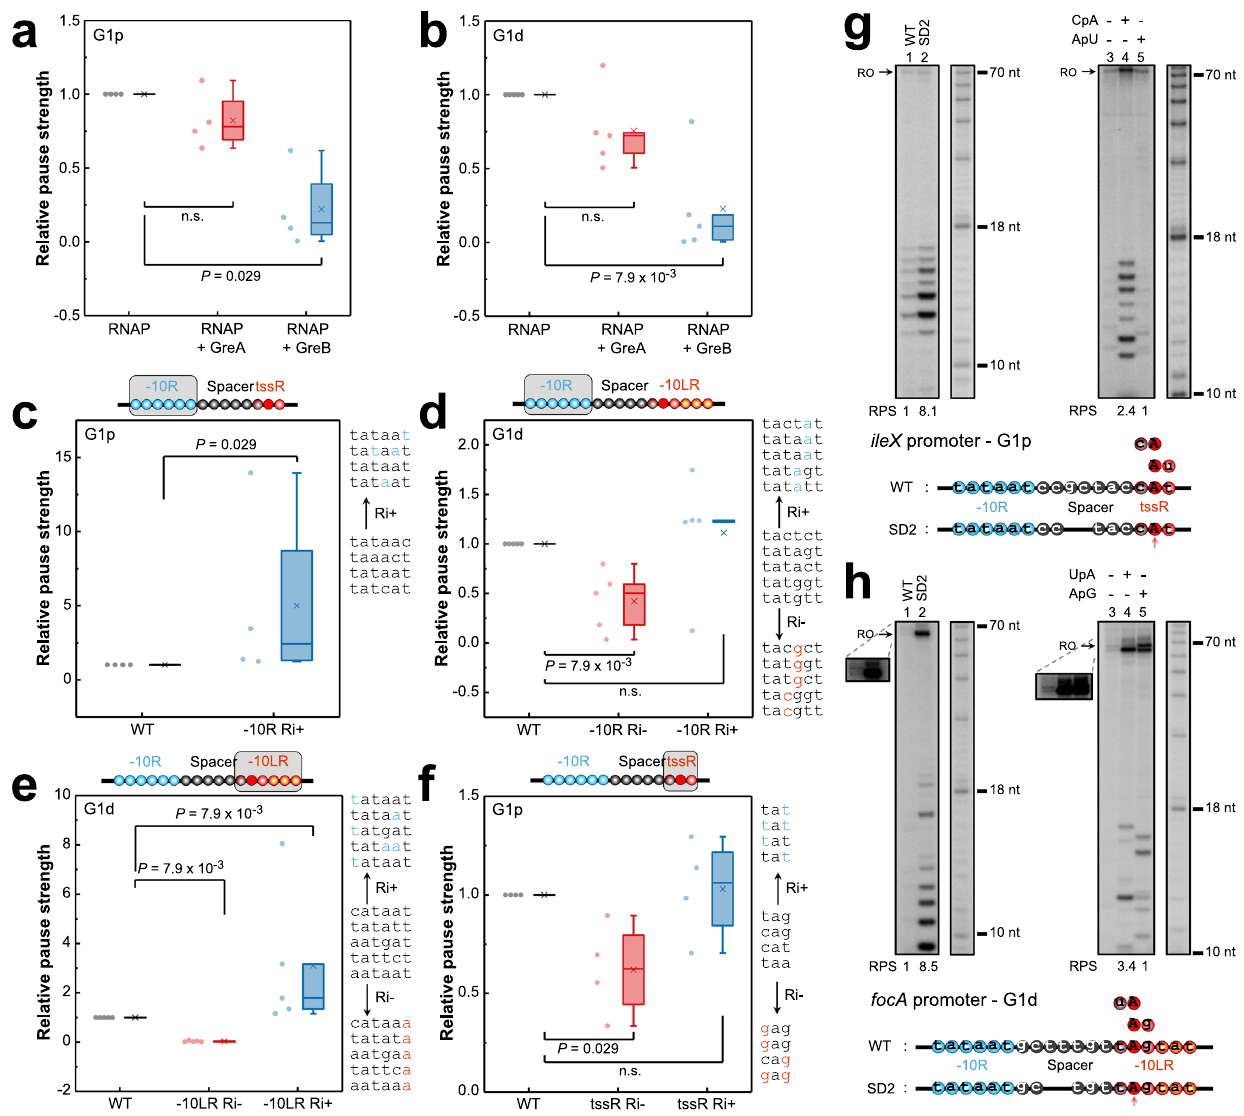
(Ri + ) or decrease (Ri − ) Ri are shown on the right in gene order. Two-tailed Mann-Whitney U -test was used for statistical analysis of the data. Effect of the spacer length on G1p ( g ) and G1d ( h ) pauses. The in vitro transcription was initiated on the WT template or on the mutant template with the shortened DNA spacer (left); different dinucleotide RNA primers overlapping the tssR were employed to alter the position of the TSS (right). The inset shows the run- off transcripts with higher exposure to visualize the faint bands. Data represent three independent experiments. Structural elements of the WT and mutated promoters are shown on the bottom. Each circle represents a single nucleotide. Open blue circles, − 10R; Dark red circle, overlapped nucleotide between spacer and tssR/ − 10LR; Open black and dark red circles, spacer; Red circles, tssR; Red and orange circles, − 10LR; Filled red circle, TSS. Red arrows indicate TSS. WT, wild-type promoter; SD2, spacer with 2-nt deletion; RPS, relative pause strength. The analysis included the data from two or more independent